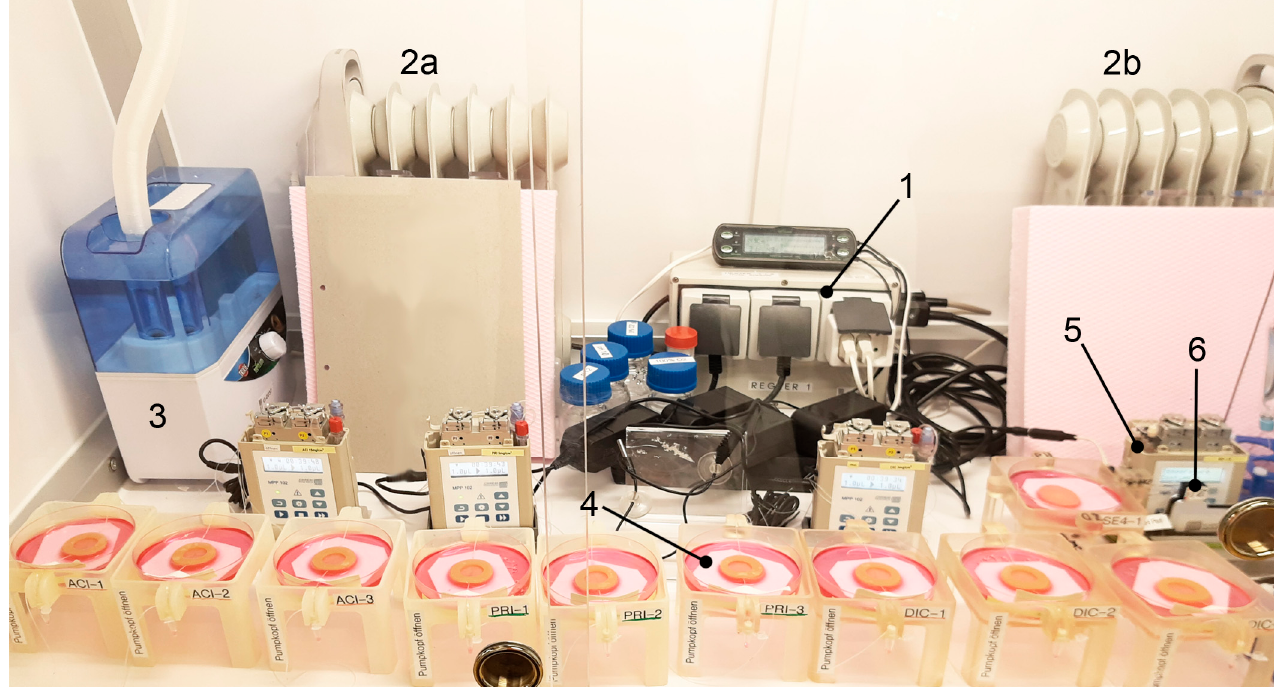
Figure 1. General setup of the ex vivo incubator with (1) climate control unit, (2a and 2b) heater, (3) humidifier (second humidifier on right not shown), (4) sampling units with FTSEs, (5) OFM pumps, and (6) online monitoring flow-through cells.